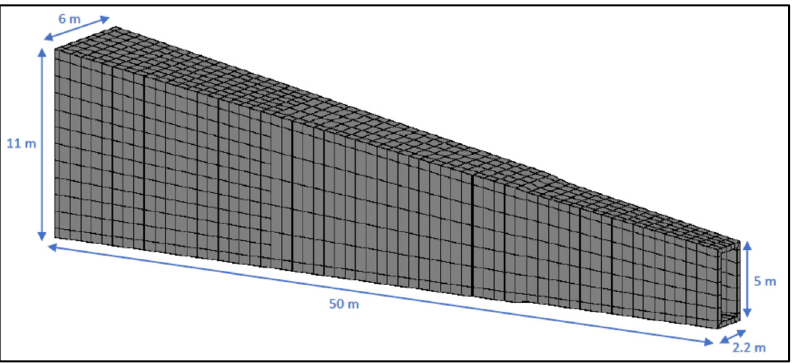
Figure 8. 3D view of the Decay Volume as implemented in the structural analysis. The box section is made up of the following members.